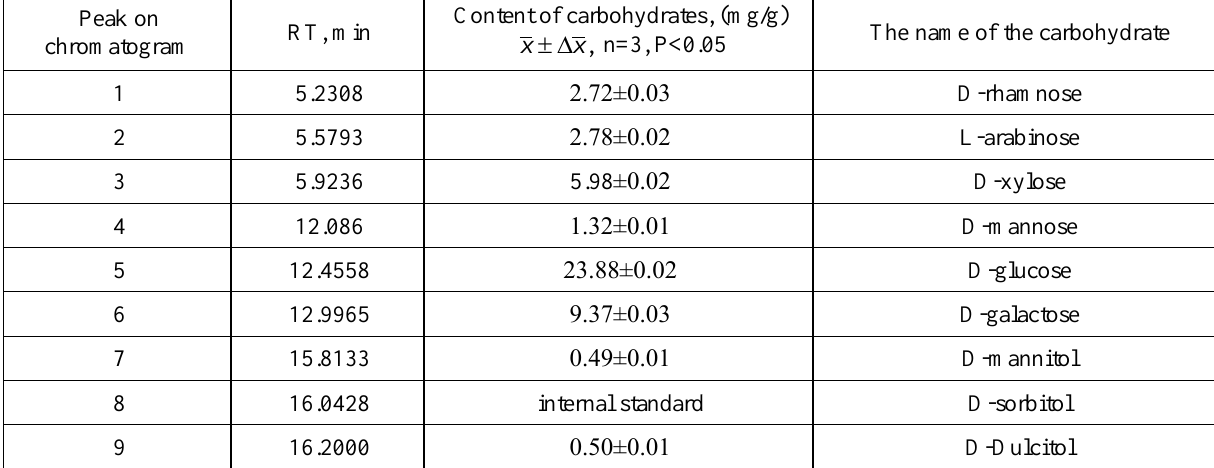
mined at 2.90±0.02 % and 8.54±0.04 % of total